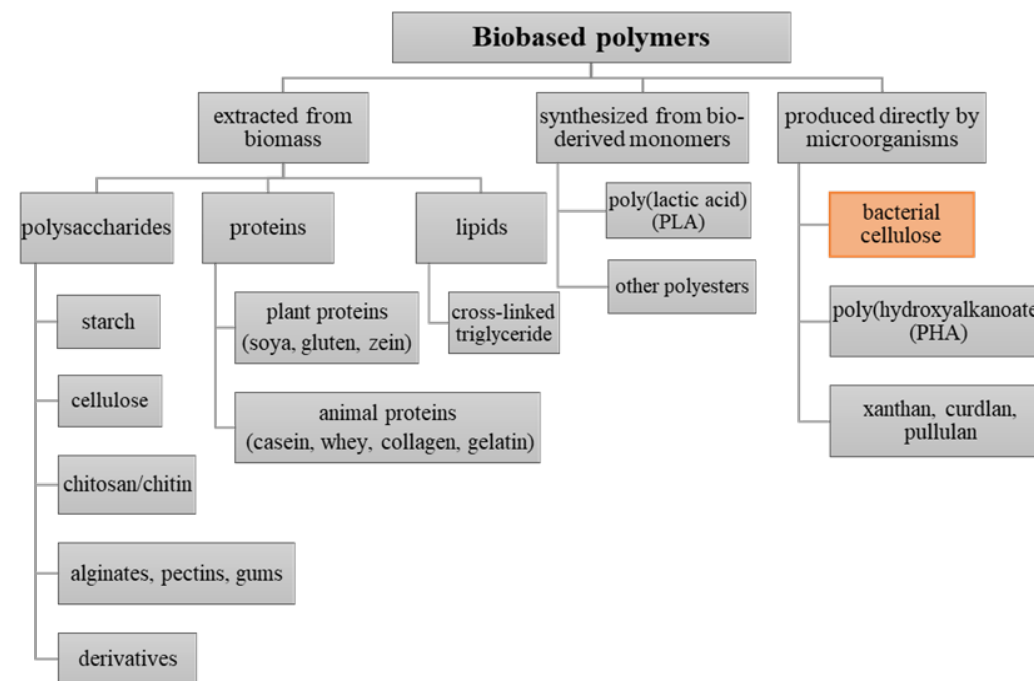
Figure 1. Schematic overview of bio-based packaging materials categorized by their origin and method of production [54,55].